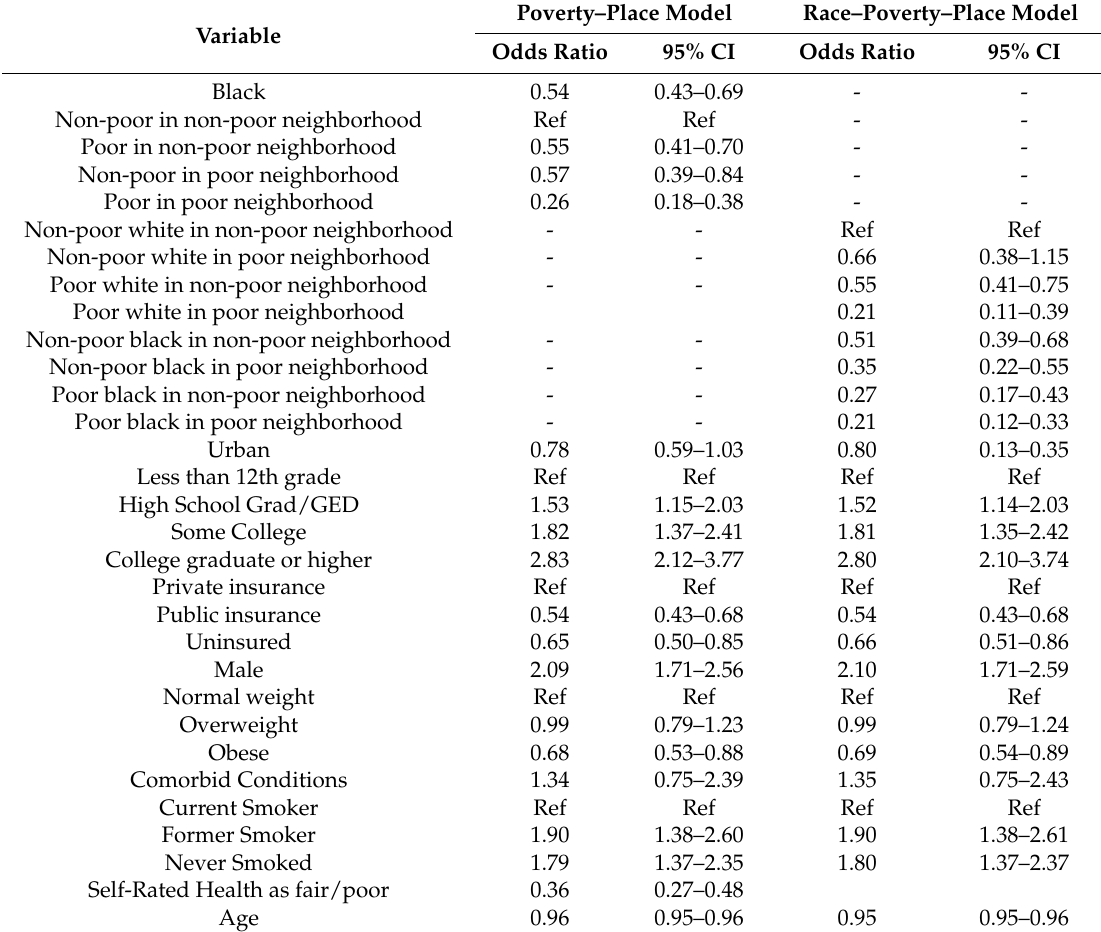
Estimated odds of being physically active controlling for poverty–place and